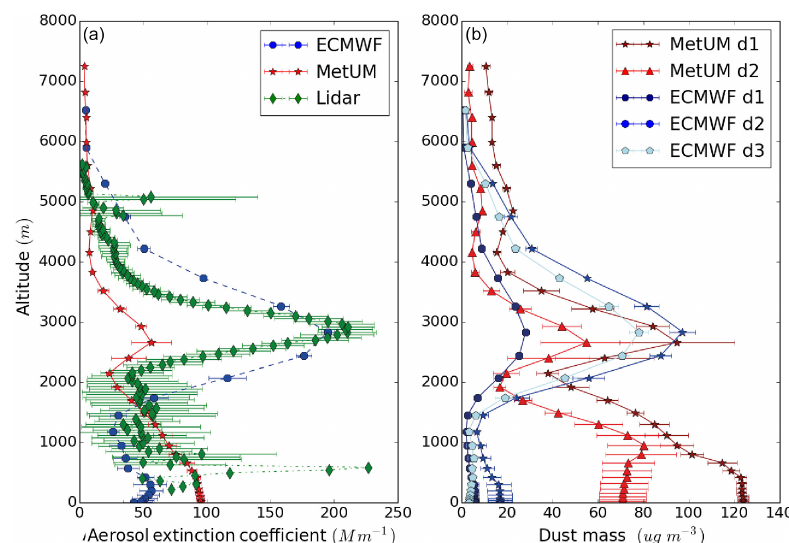
Figure 13. Case study 3, B927, 15 August, R1: (a) mean and standard deviation of the lidar (green), MetUM (red), and ECMWF (blue) extinction profiles. (b) Modelled MetUM dust concentration for divisions 1 (dark red) and 2 (red), as well as modelled ECMWF concentration for divisions 1 (dark blue), 2 (blue), and 3 (light blue)